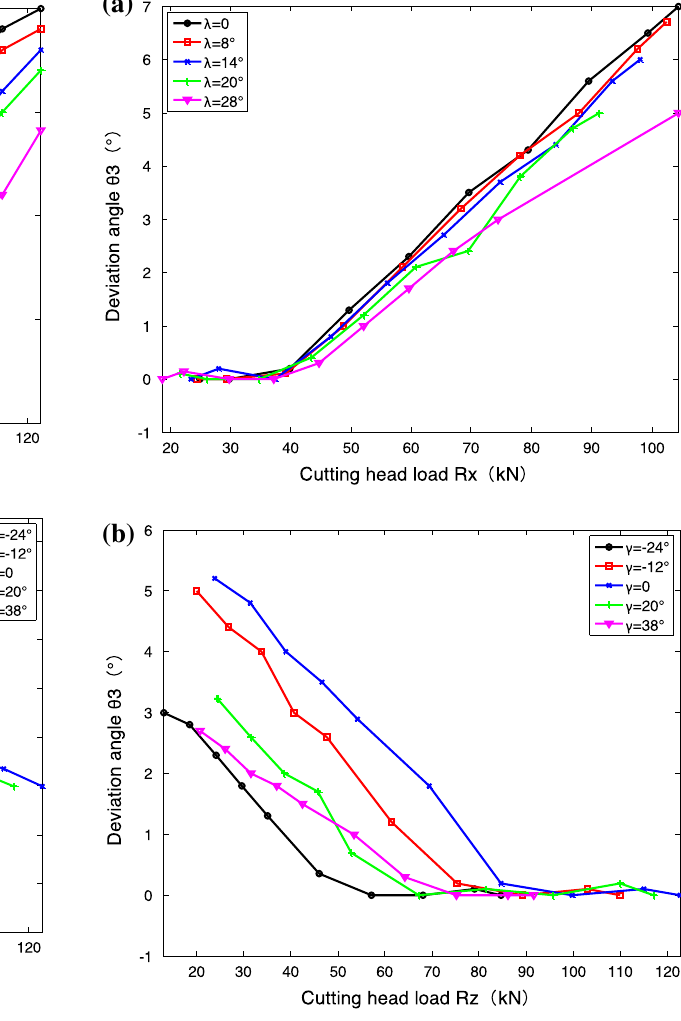
Fig. 19 Experimental results of the roll angle. ( a ) During horizontal cutting process; ( b ) During vertical cutting process Fig. 20 Experimental result of the deviation angle. ( a ) During hori- zontal cutting process; ( b ) During vertical cutting